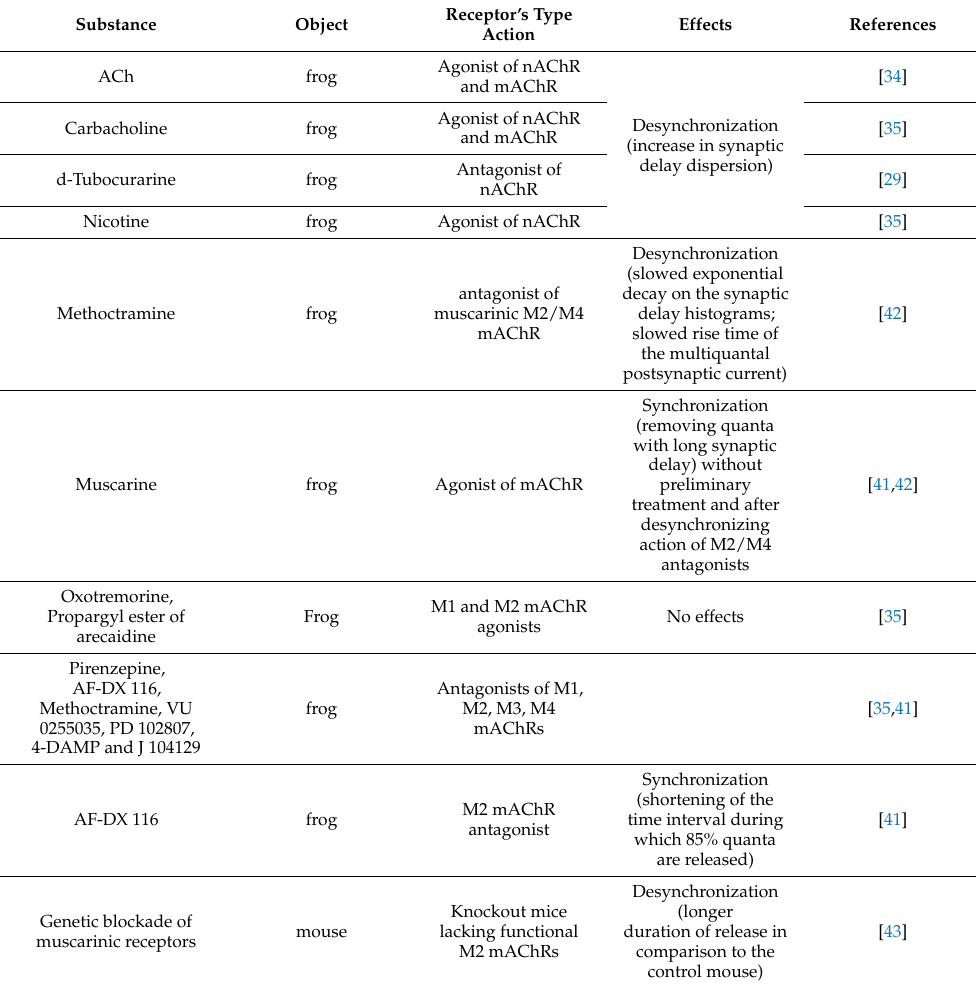
Table 1. Effects of agonists and antagonists of AChRs on the time course of the evoked ACh quanta